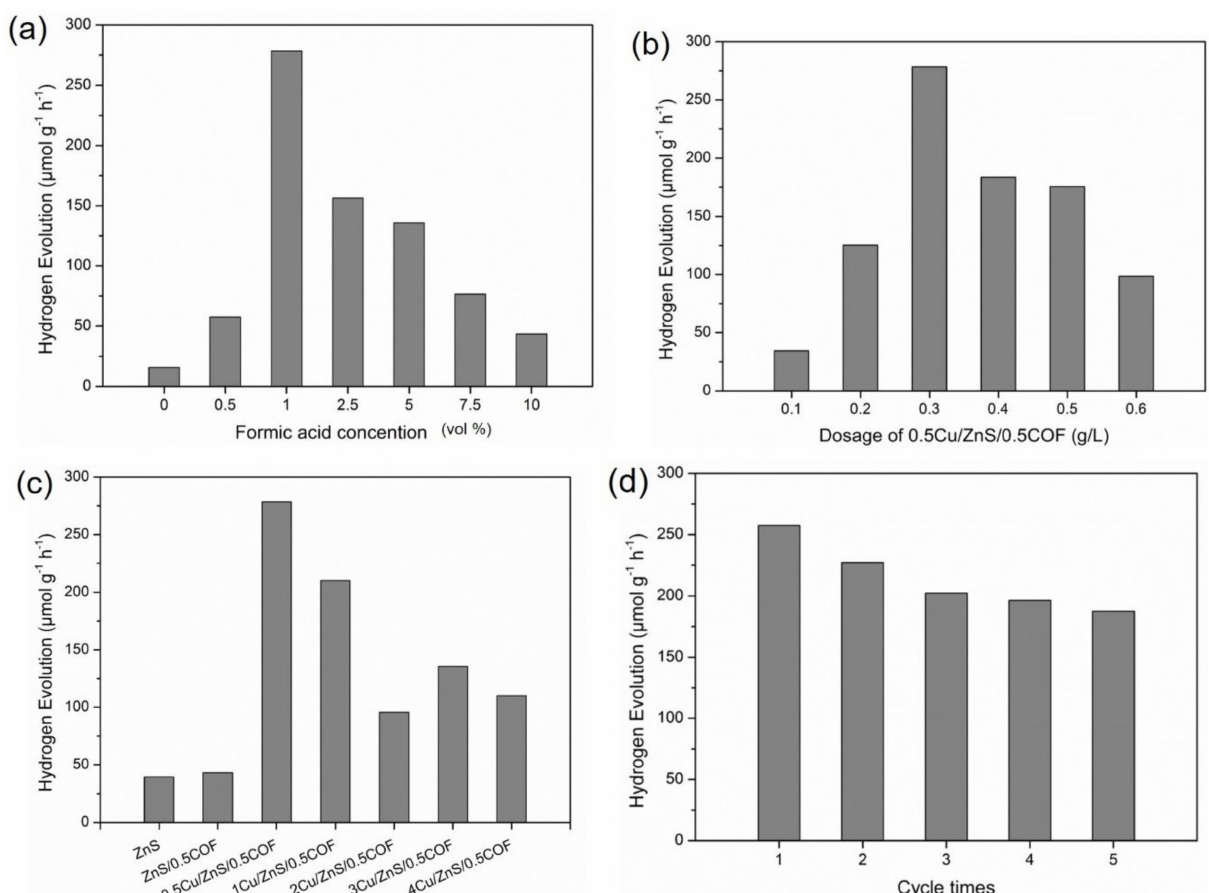
Figure 6. ( a ) Effect of formic acid concentration on the hydrogen production rate of 0.3 g/L 0.5Cu/ZnS/0.5COF composite photocatalyst. ( b ) Effect of 0.5Cu/ZnS/0.5COF composite photocatalyst dosage at 1 M formic acid on hydrogen production rate. ( c ) Photocatalytic hydrogen evolution activities of as-synthesized photocatalysts. ( d ) Cycle runs for hydrogen evolution of 0.5Cu/ZnS/0.5COF